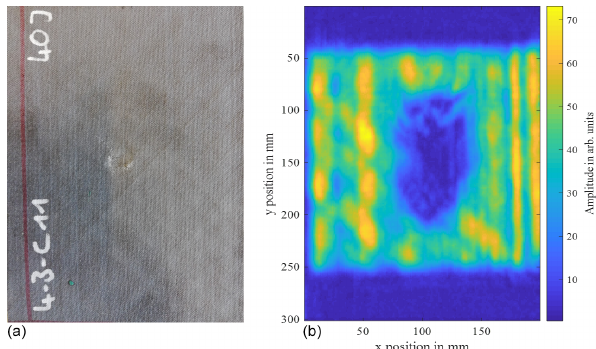
Figure 9. Photography of the tested CFRP plate (a) . C scan of the tested plate (b)